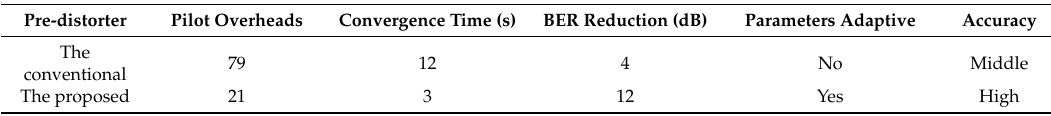
Table 2. Performance